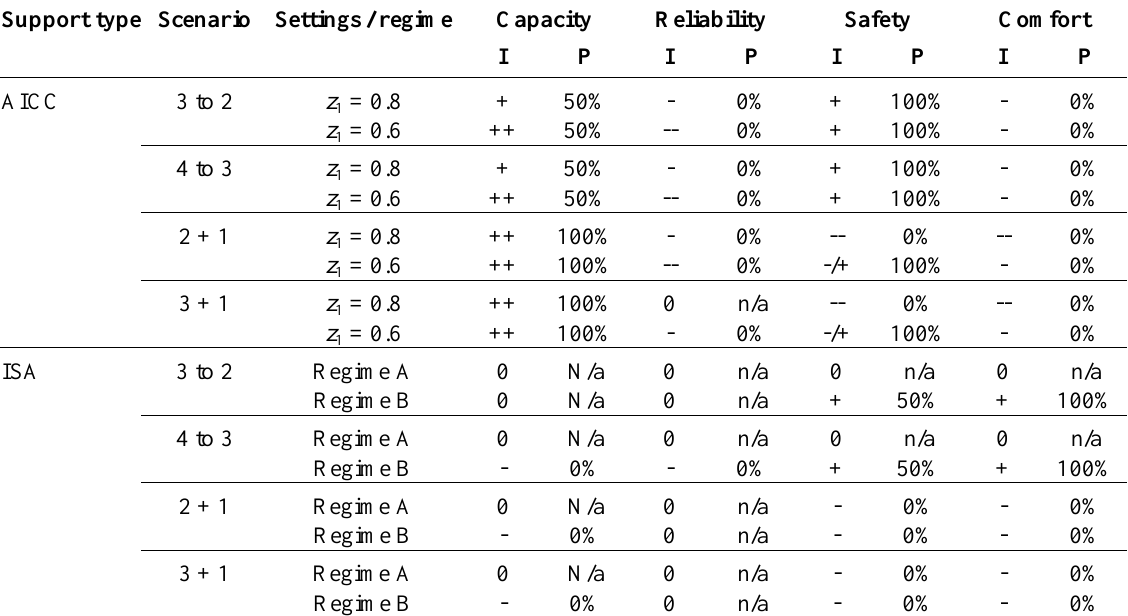
Table 2 Overview results ADAS on botteneck capacity and reliability, safety, and comfort (I: expected impact, P: optimal penetration level). The plusses and minusses indicate to which extent the results are